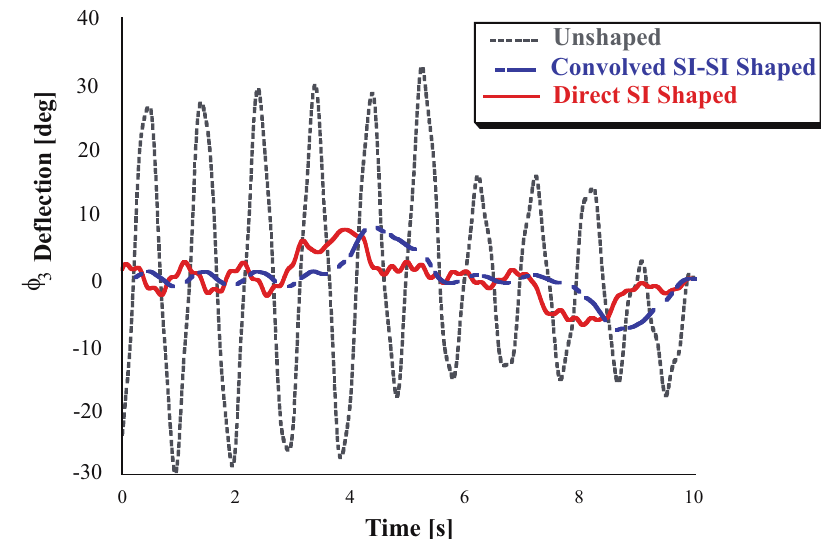
Figure 23. Comparison of Direct SI Shaped and Unshaped φ 3 or θ 2 Deflection-Limited and Unlimited Responses.